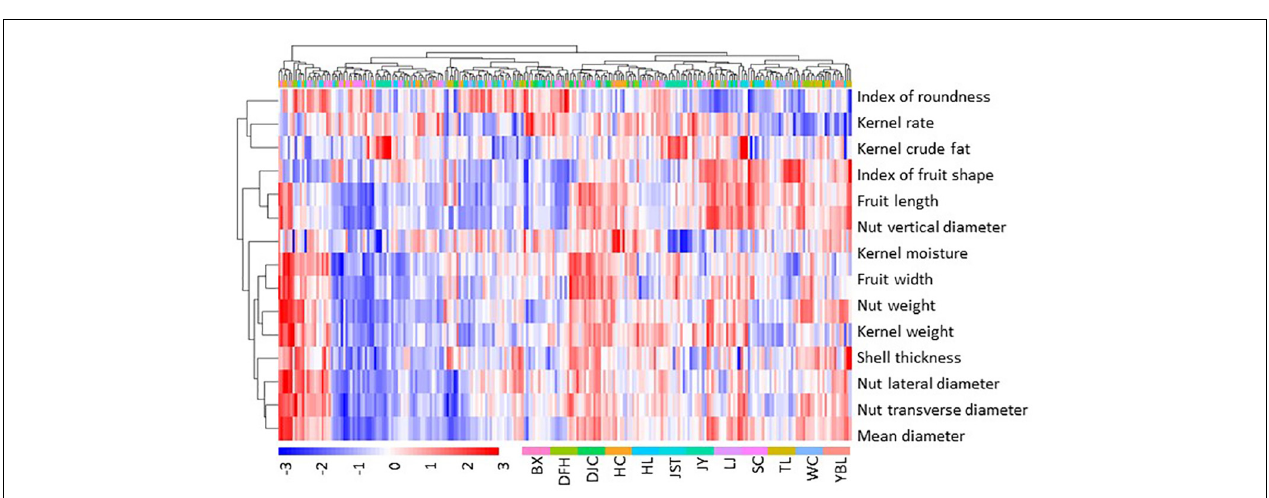
FIGURE 2 | Heatmap of fruit morphology. Fruit morphology data were scaled by subtracting the mean. Thus, positive values indicate above the mean (red), and negative values indicate below the mean (blue). Data of individual trees from each site, color coded as shown in the bottom of the figure, were used. BX, Binxian, HLJ; DFH, Raohe, HLJ; DJC, Ning’an, HLJ; HC, Hunchun, JL; HL, Hulin, HLJ; JST, Yichun, HLJ; JY, Jiayin, HLJ; LJ, Linjiang, JL; SC, Baishan, JL; TL, Tieli, HLJ; WC, Wuchang, HLJ; YBL, Yabuli, HLJ. HLJ, Heilongjiang province; JL, Jilin province.